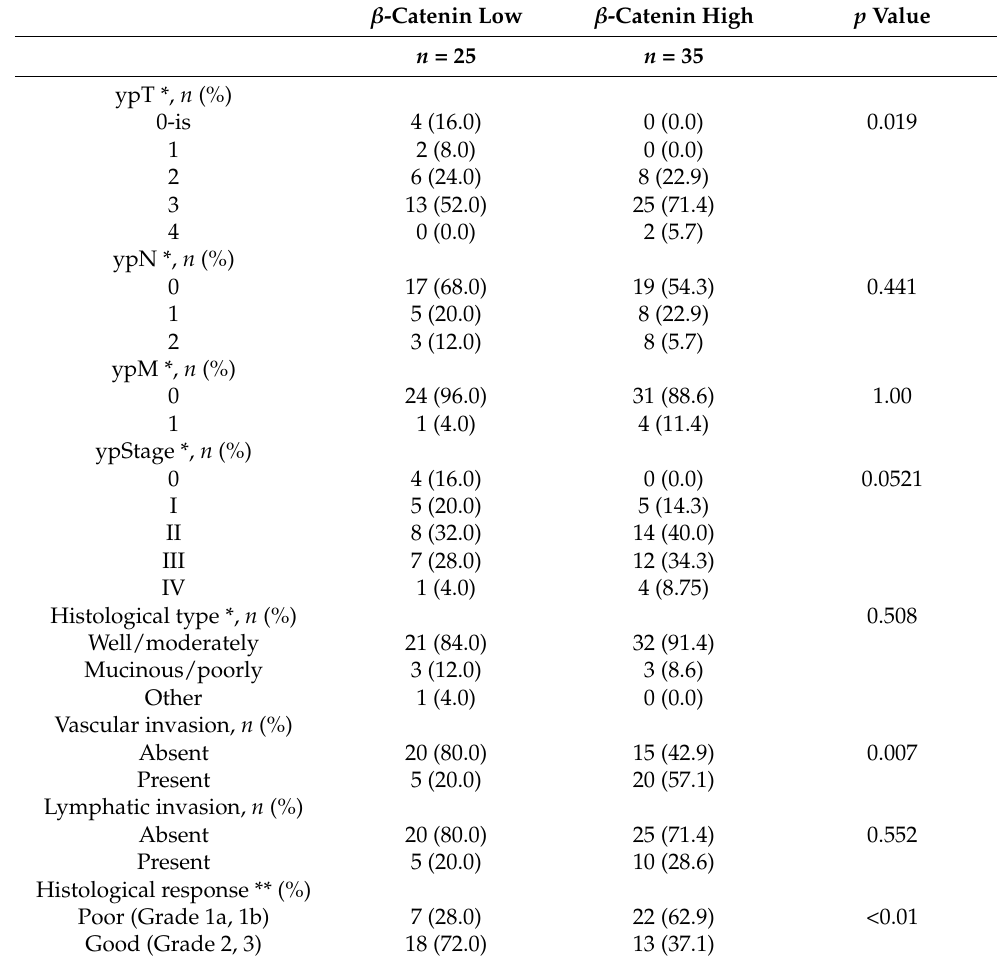
Table 4. Pathological